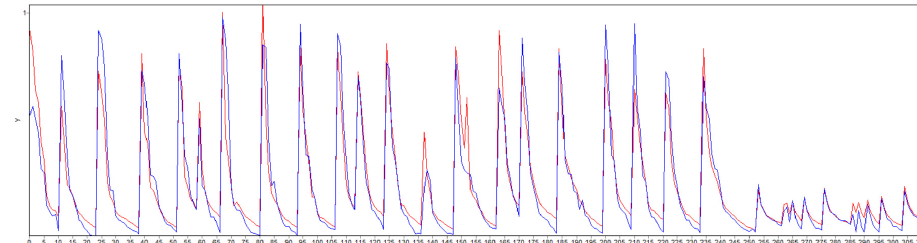
Figure 12. Fitting of the new model when the pipe diameter was 60 mm. The blue line represents the fitted value, and the red line represents the experimental value. The x-axis represents the number of iterations, and the y-axis represents the value of the result.